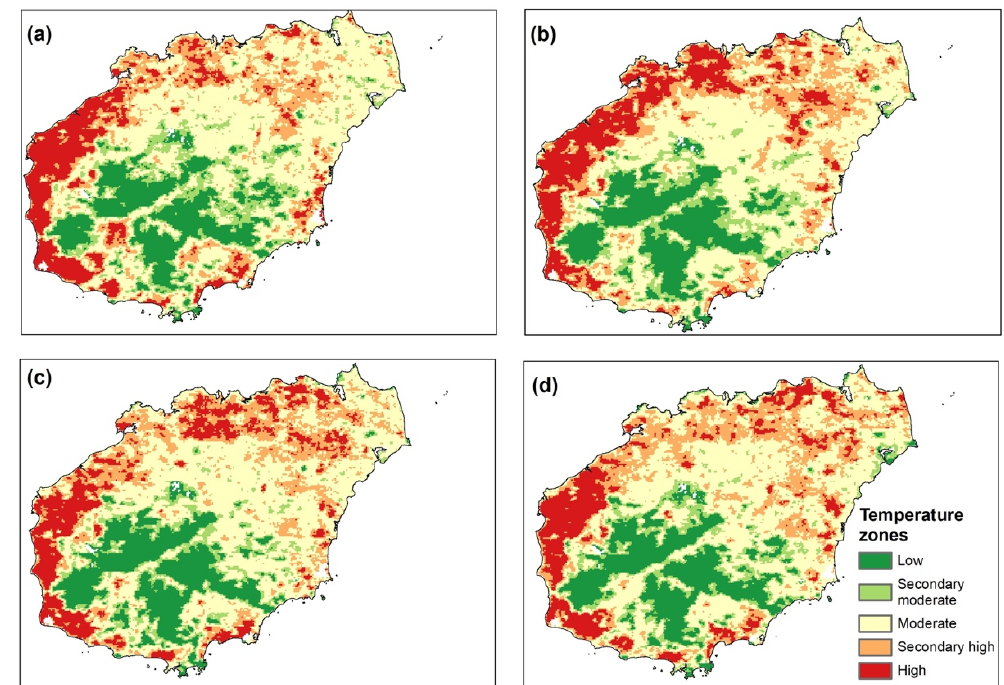
Figure 4. The LST pattern changes at the four years of 2000 ( a ), 2006 ( b ), 2012 ( c ), and 2016 ( d ). Table 4. Statistics of the pixel in the five temperature zones for the years 2000, 2006, 2012 and 2016.